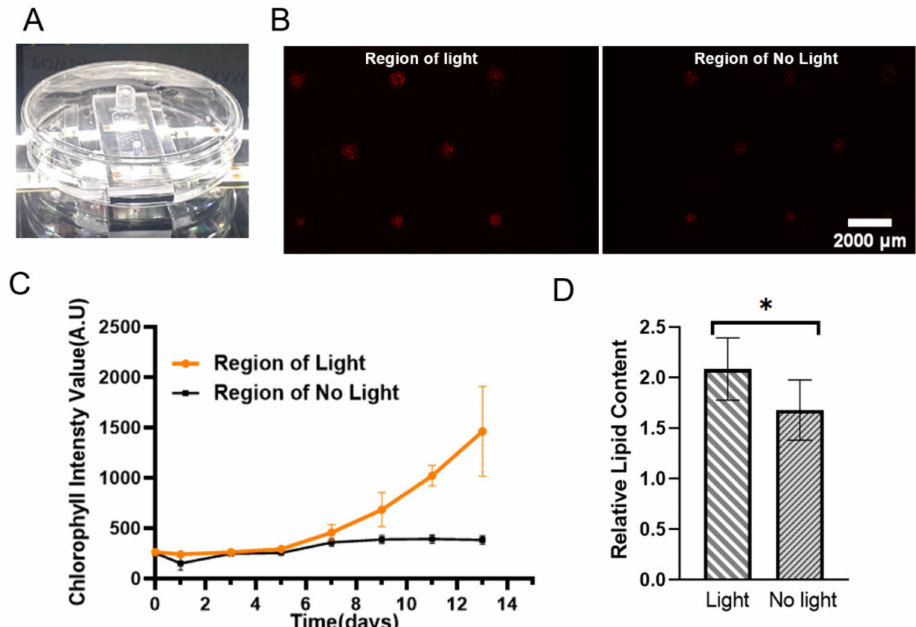
Figure 4. Formation of cell aggregate in the chip with regions of light and no light and the growth curve. ( A ) Experimental setup of chip with LED light source. ( B ) Formation of algal cell aggregate within the wells in the chip, which was observed at wavelength 645 nm with region of presence and absence of light on the fourteenth day of culture. ( C ) Comparison of curves of growth rate in the presence and absence of light ( n = 54). ( D ) Comparison of lipid content of algae grown in a region of the presence and absence of light (* indicated p -value < 0.05, n =